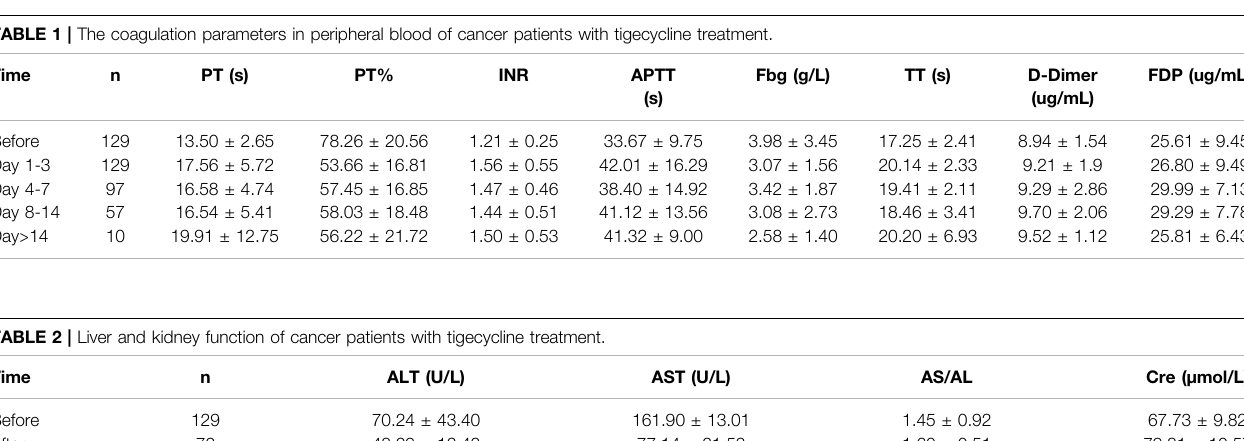
TABLE 1 | The coagulation parameters in peripheral blood of cancer patients with tigecycline treatment. Time n PT (s) PT% INR APTT Before